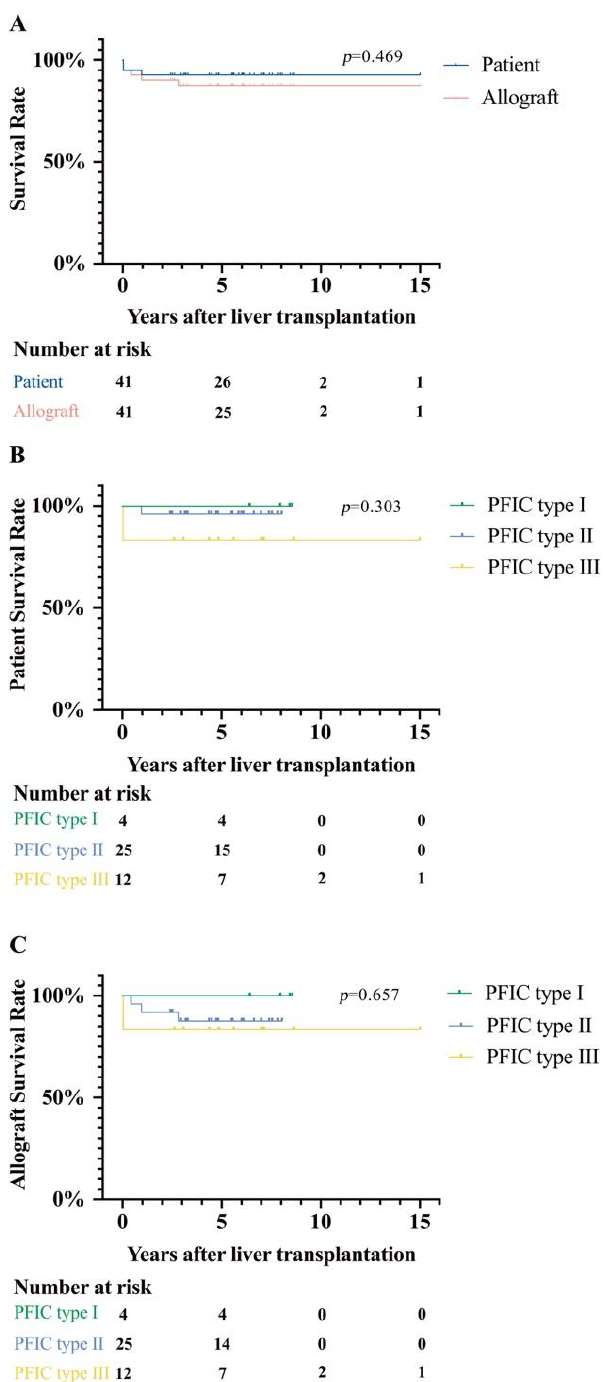
Figure 1. Patient and allograft survival rates after LT. ( A ) Overall PFIC patient survival rates were 92.7% and 92.7% at 5 and 10 years after LT, respectively. The longest follow-up time is 15 years after LT. Allograft survival rates of PFIC patients were 87.8% and 87.8% at 5 and 10 years, respectively. ( B ) Patient survival rates of three subtypes of PFIC patients. PFIC type I patient survival rate (4 patients in total) was 100.0% at 5 years after LT. PFIC type II patient survival rate (25 patients in total) was 96.0% at 5 years after LT. PFIC type III patient survival rate (12 patients in total) was 83.3% at 5 years after LT. ( C ) Allograft survival rates of three subtypes of PFIC